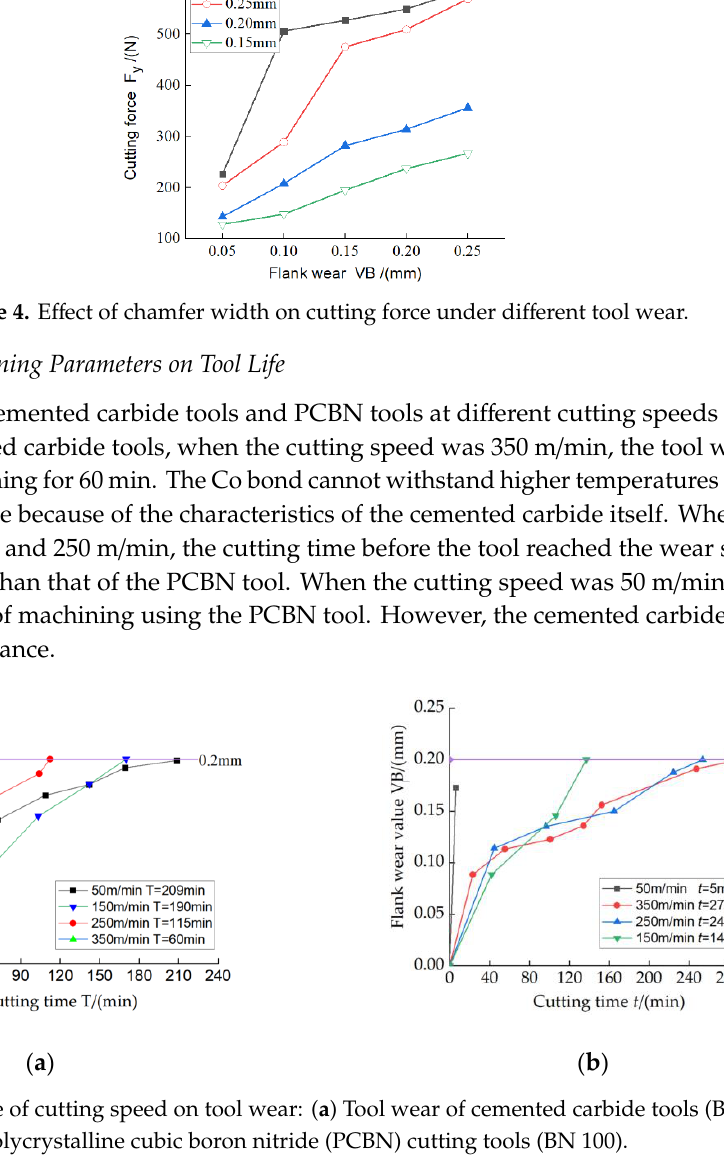
Figure 5. Influence of cutting speed on tool wear: ( a ) Tool wear of cemented carbide tools (BNM 200); ( b ) Tool wear of polycrystalline cubic boron nitride (PCBN) cutting tools (BN 100).